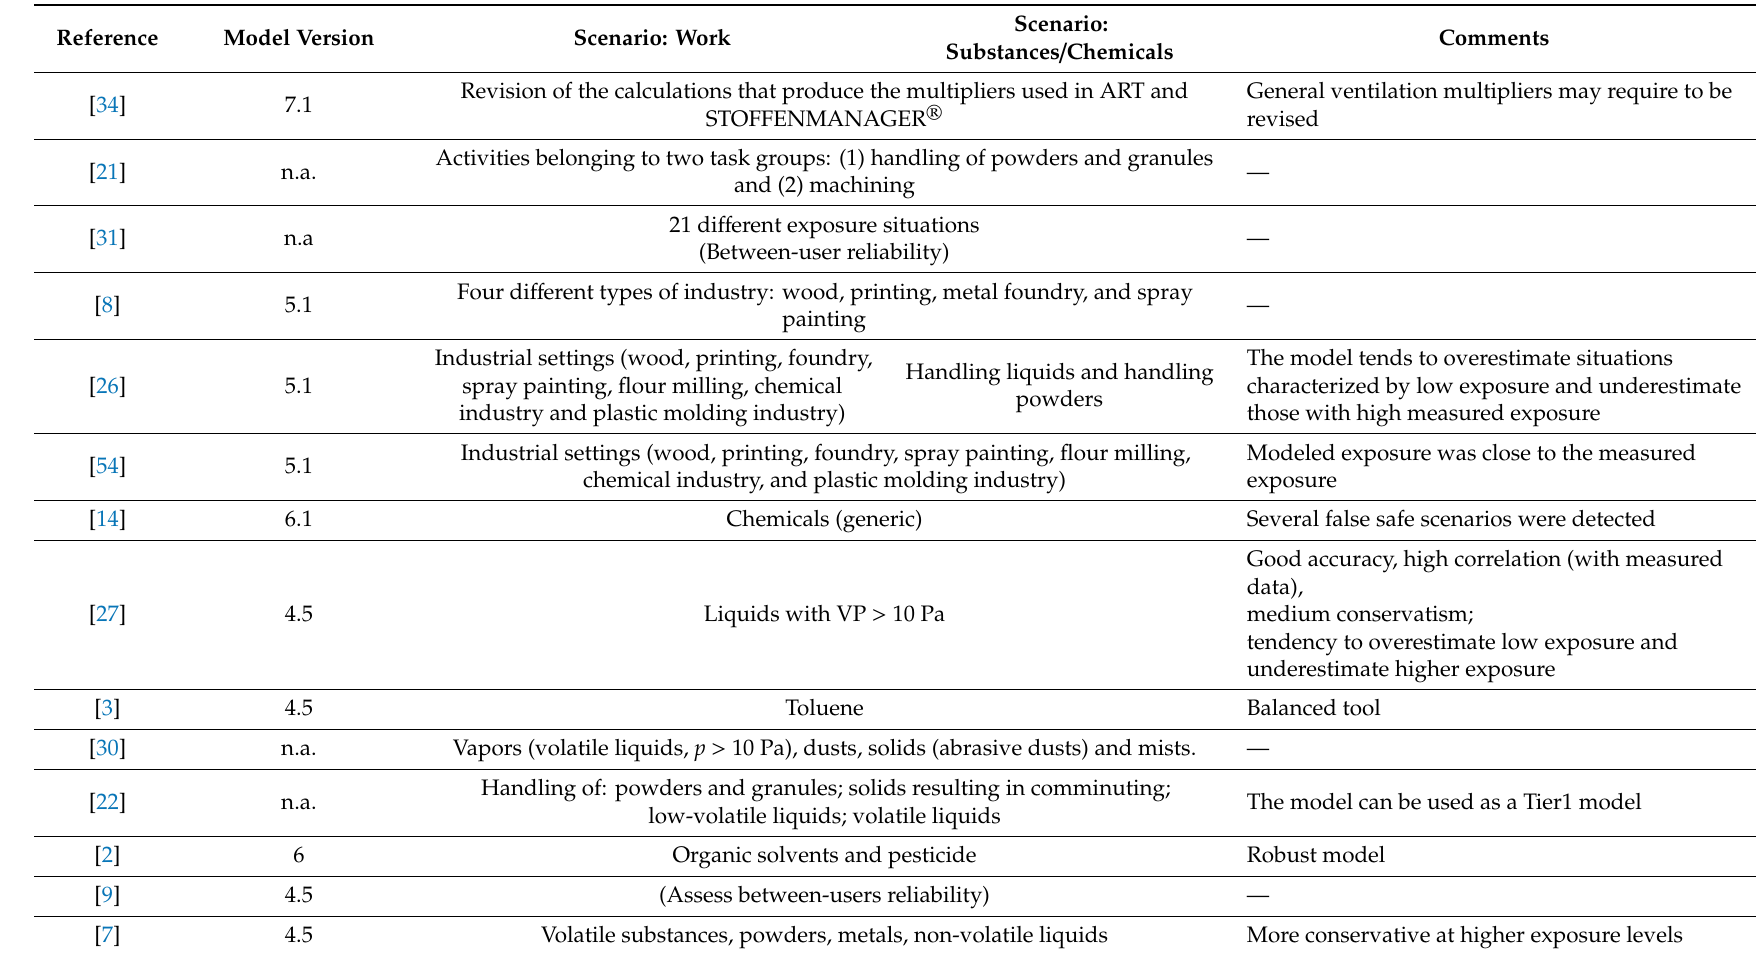
Table 9. Summary of articles about the STOFFENMANAGER ® model found in the present